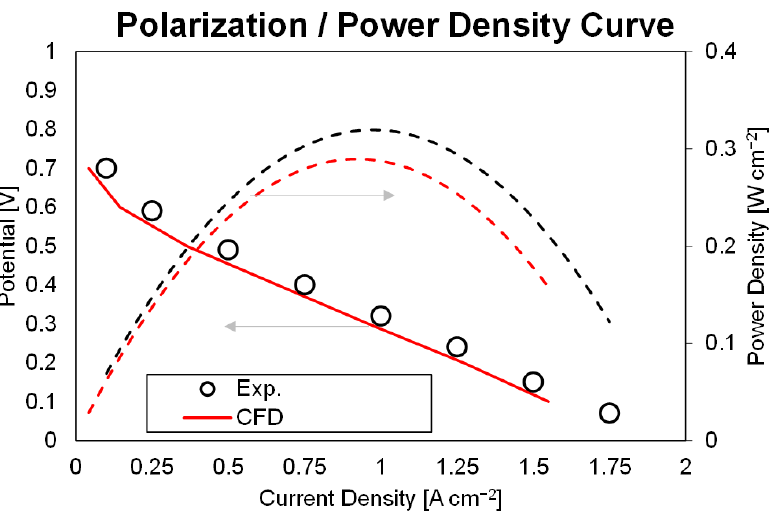
Figure 11. Polarization curve and electric power density for experiments and simulations. Model Results with Improved Exchange Current Density